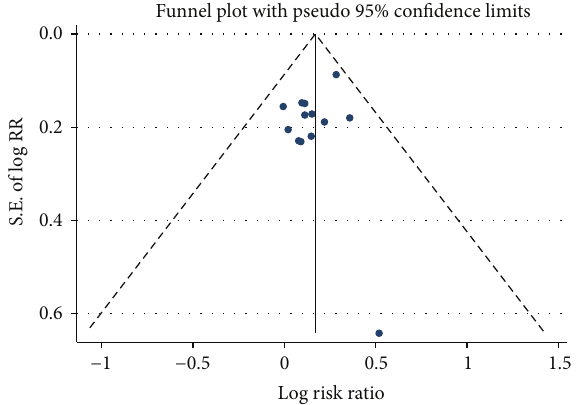
Figure 3: Funnel plot analysis. Funnel plot and Egger’s test showed no evidence of publication